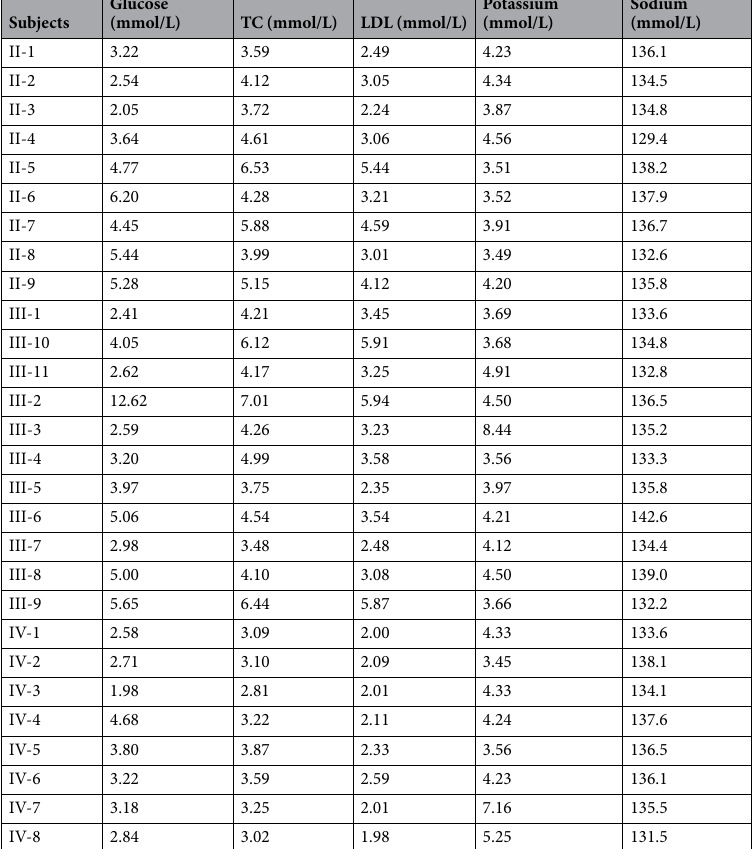
Table 3. Biochemical test for members in this Chinese Pedigree. TC: total cholesterol; LDL: low-density lipoprotein.